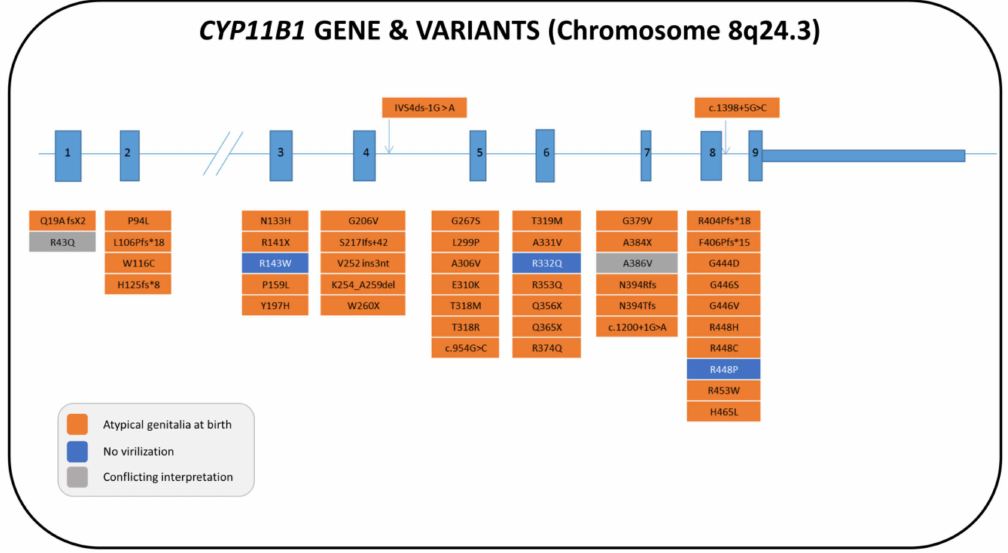
Figure 5. Structure of the human CYP11B1 gene with the pathogenic variants that have been described in 46,XX patients. The nomenclature of the pathogenic variations is given according to the references cited in Table S2. The nomenclature and the color of the boxes of each pathogenic variant are in accordance with the phenotypic characteristics described in each patient, the variant present on the second allele and the references cited in Table